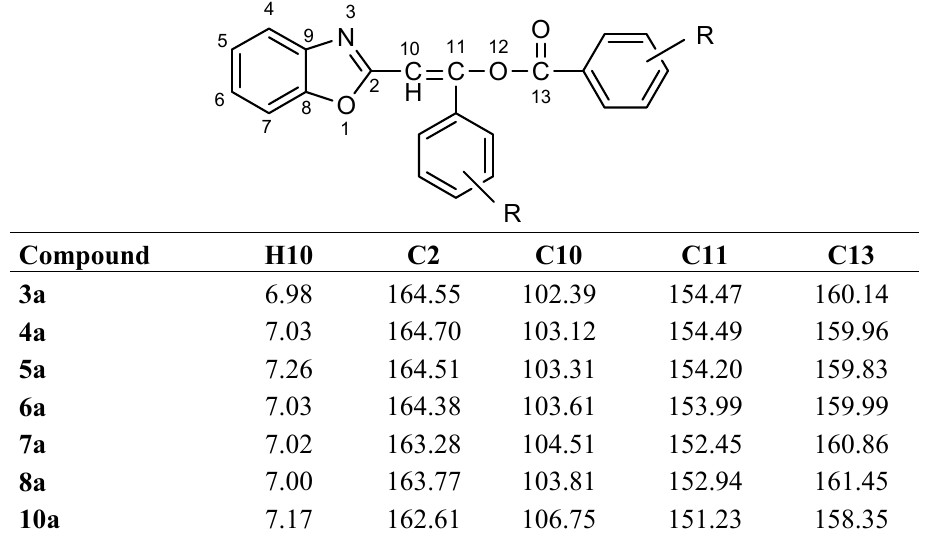
Table 2. Selected 1 H and 13 C NMR chemical shifts ( δ from TMS) for 0.1–0.2 M solutions